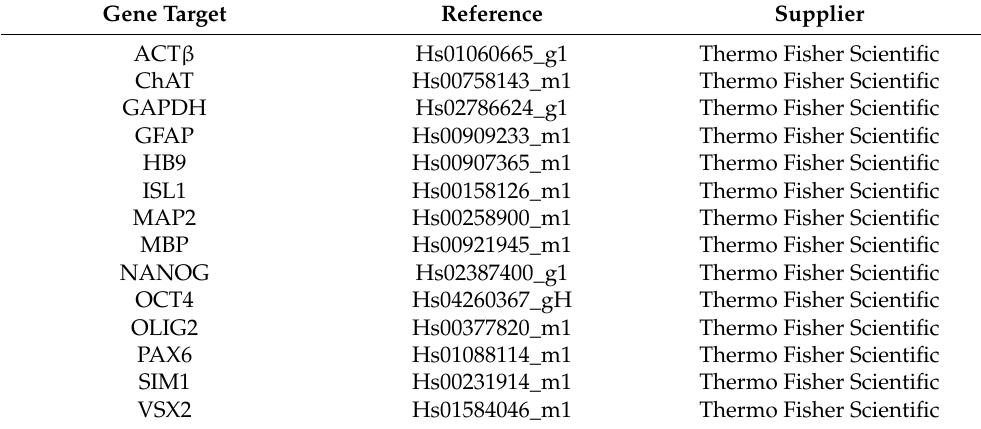
Table 4. Probes/primers